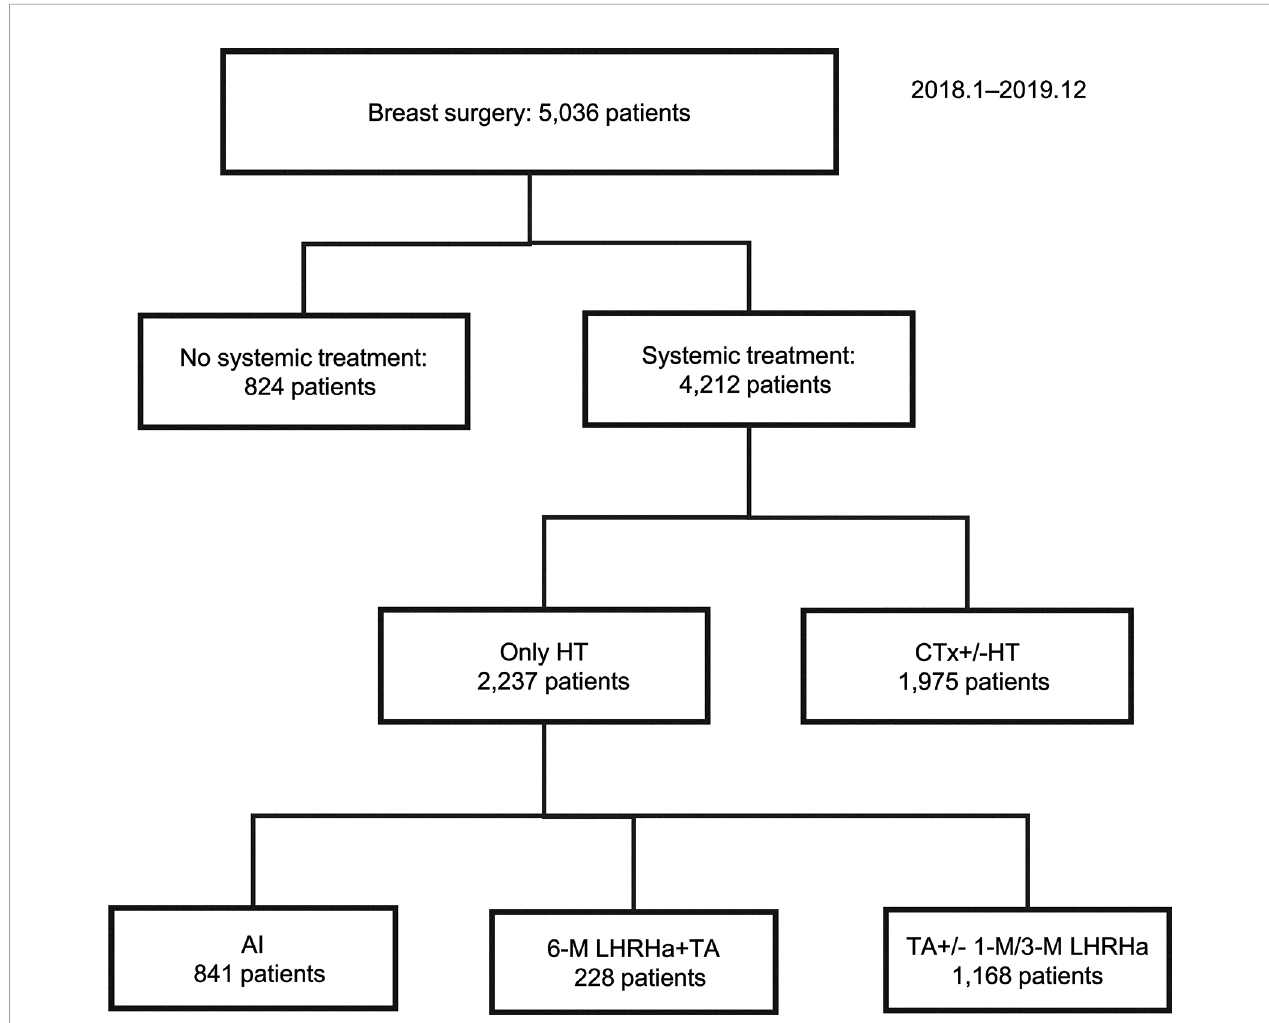
FIGURE 1 | Summary of enrolled patients. AI, aromatase inhibitor; CTx, chemotherapy; HT, hormonal therapy; LHRHa, luteinizing hormone-releasing hormone analog; M, month; TA,